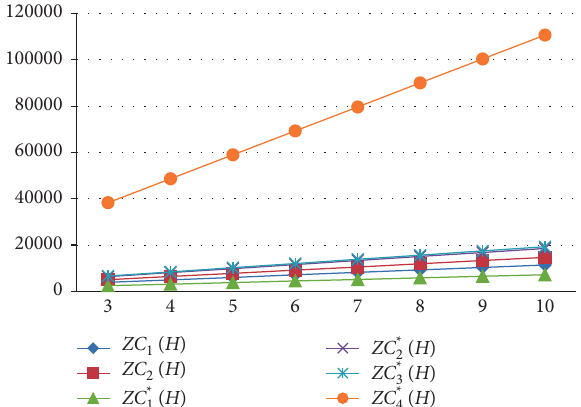
Figure 5: Comparison of ZC ∗ dimensions 3 ≤ n ≤ 10.